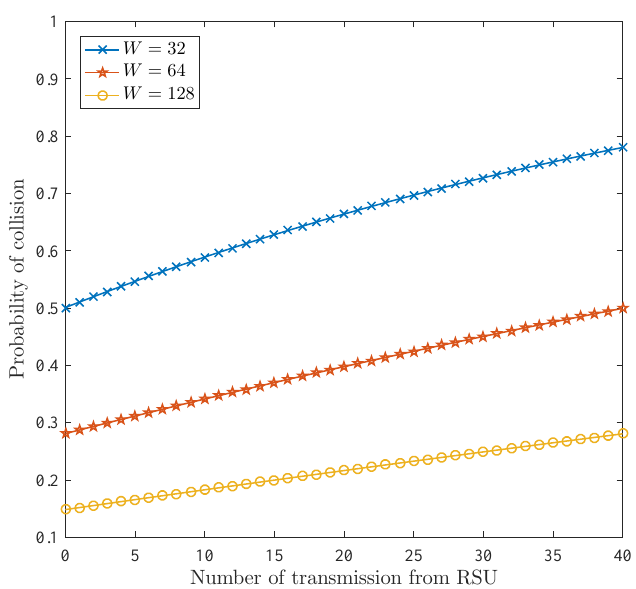
Figure 6. Probability of collision with different sizes of contention window (for N = 40).